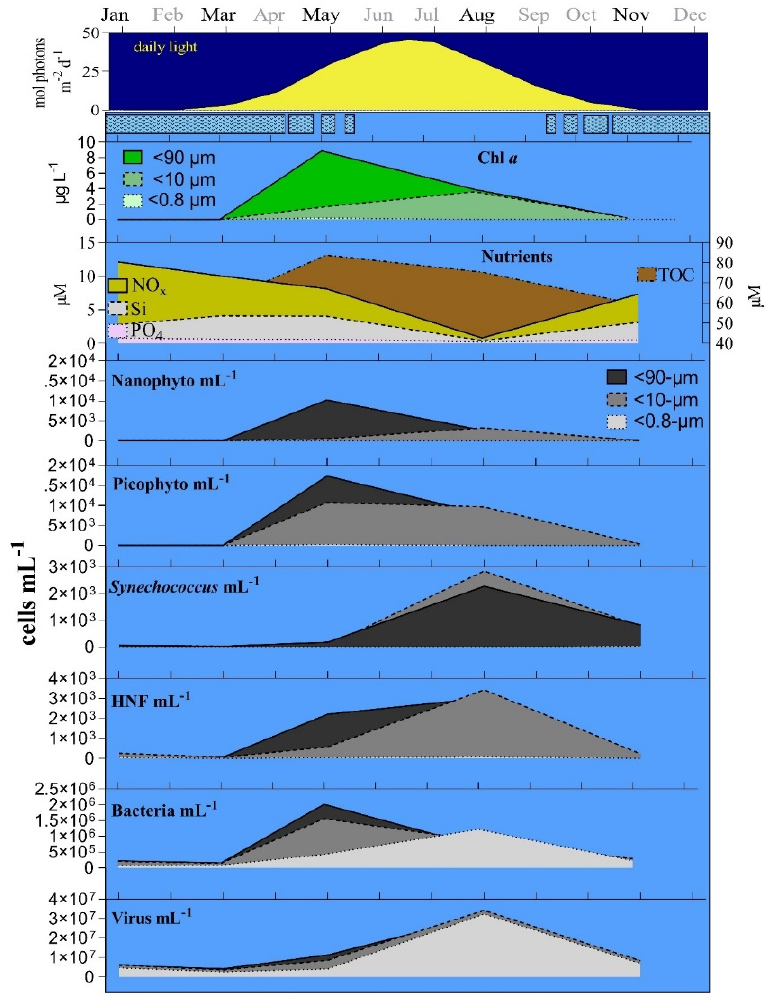
Figure A1. From top to bottom, annual change in the light, chlorophyll a, nutrients (left y-axis) and DOC (right y-axis) and the abundance of microbial organisms in the three fractions of the experiments (<0.8 µ m (light green and light grey), 3–10 µ m (green and grey) and <90 µ m (dark green and dark grey)) carried out during five months (marked in black). Data points represent the measurements after six days of incubation. Chl a = Chlorophyll a ; DOC = total dissolved organic carbon; NOx = nitrate and nitrite; Si = silicate; PO 4 = phosphate; Nanophyto = nanophytoplankton; Picophyto = picophytoplankton; HNF = heterotrophic